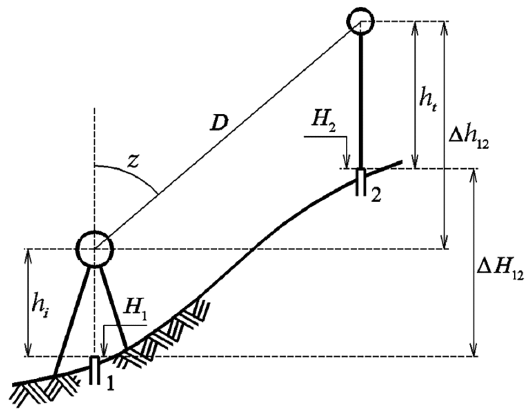
Figure 1. Trigonometric determination of height